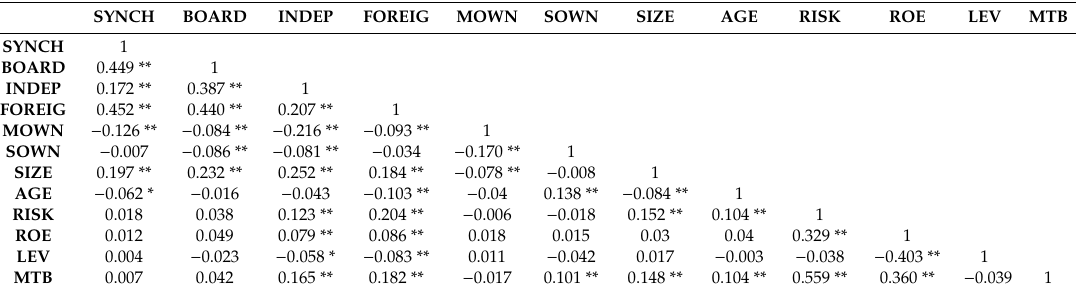
Table 3. Correlations between